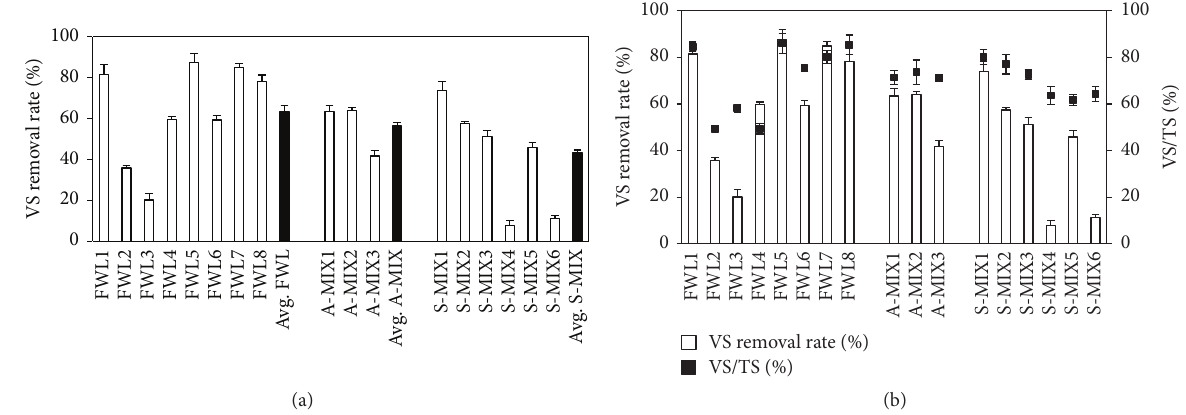
Figure 2: Volatile solid removal rates of individual anaerobic digestion facilities: (a) comparison with 65% volatile solid removal rate of Korea Waste Act; (b) comparison with volatile solid/total